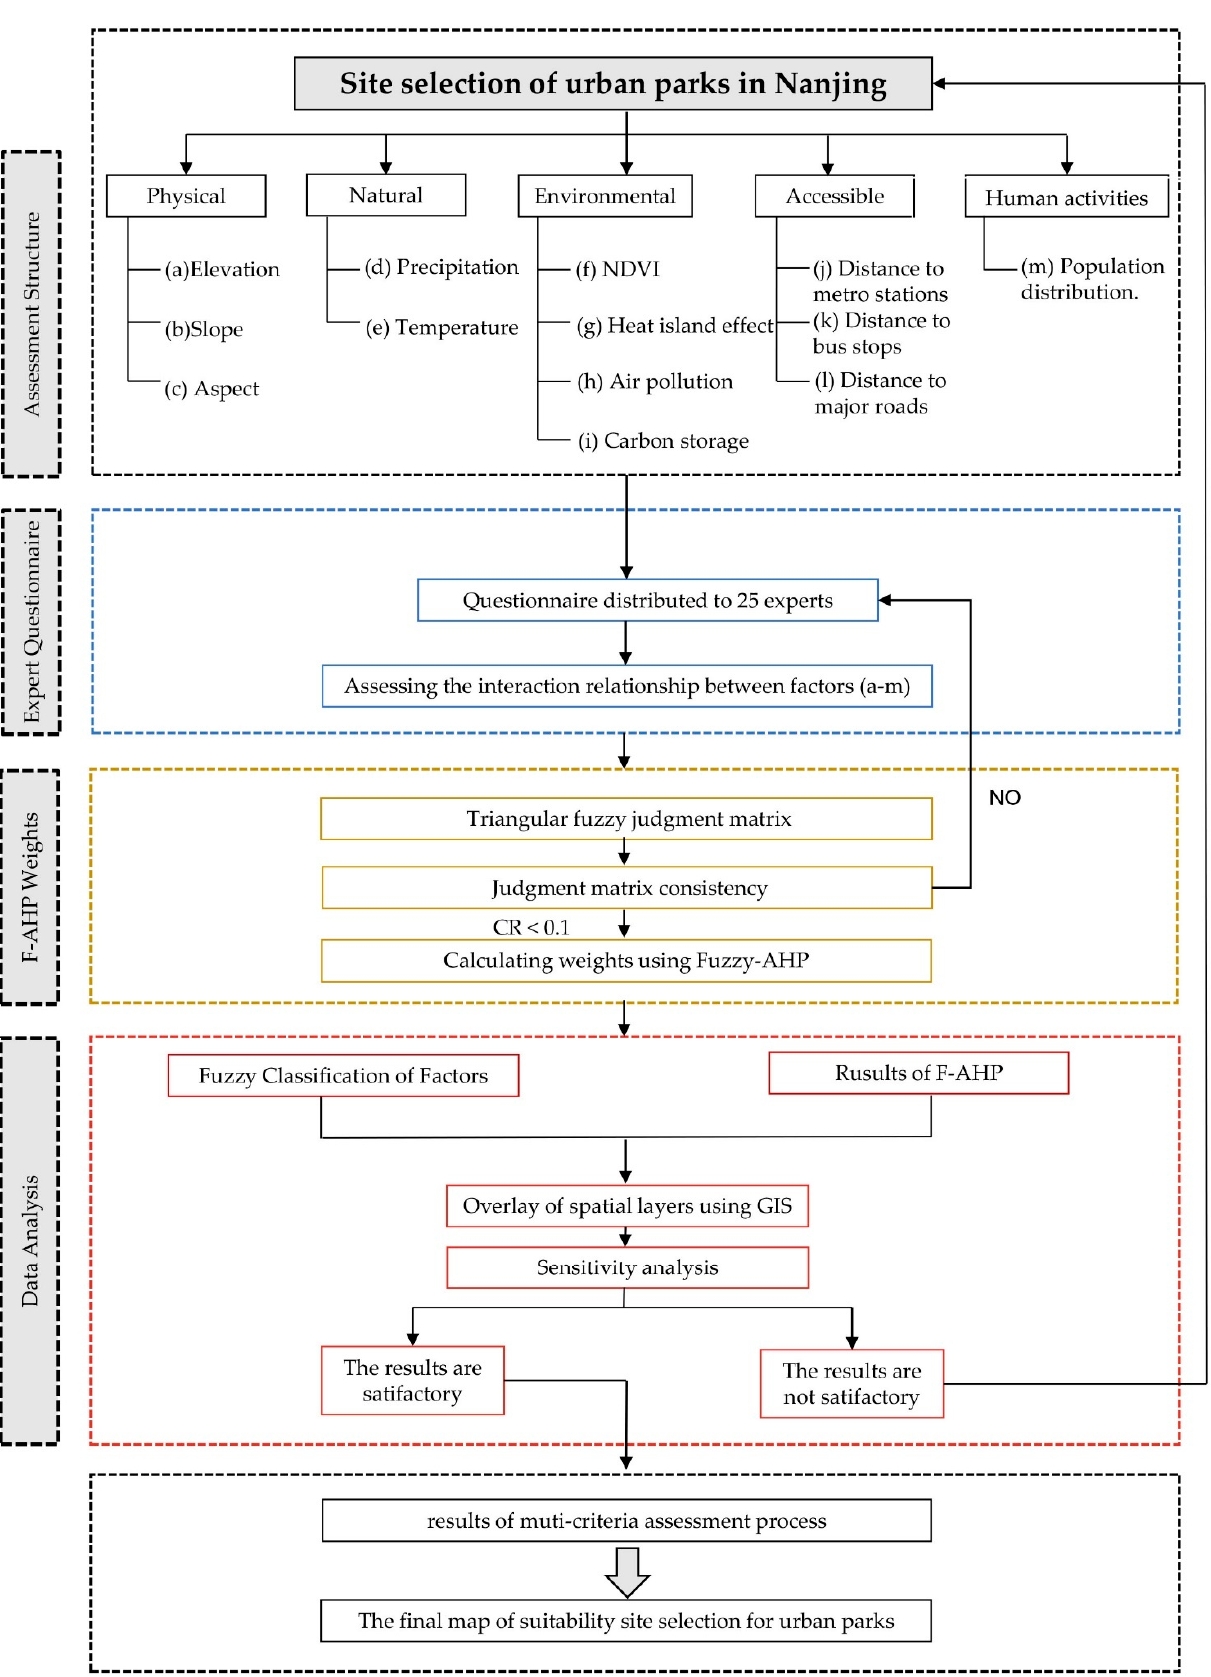
Figure 1. Flow Chart of urban park site selection evaluation in Nanjing.